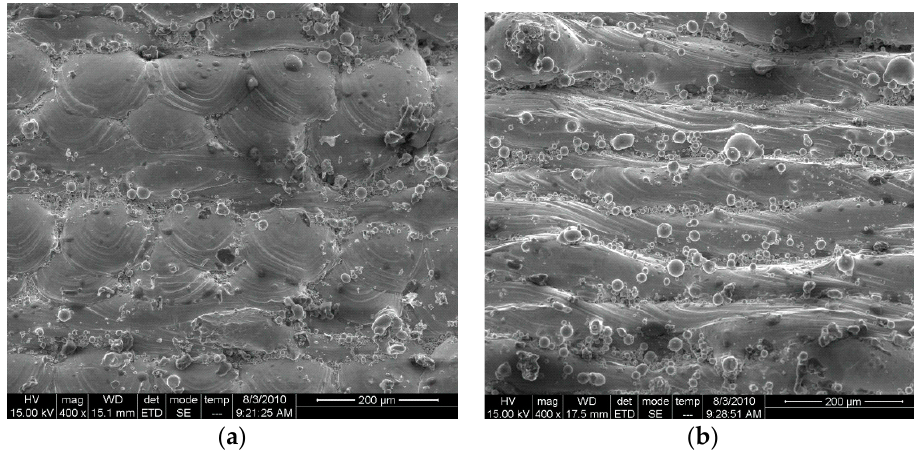
Figure 4. Microscopic analysis of surface morphology of stainless steel parts from SLM. ( a ) Surface morphology of the side part; and ( b ) surface morphology of the upper part.